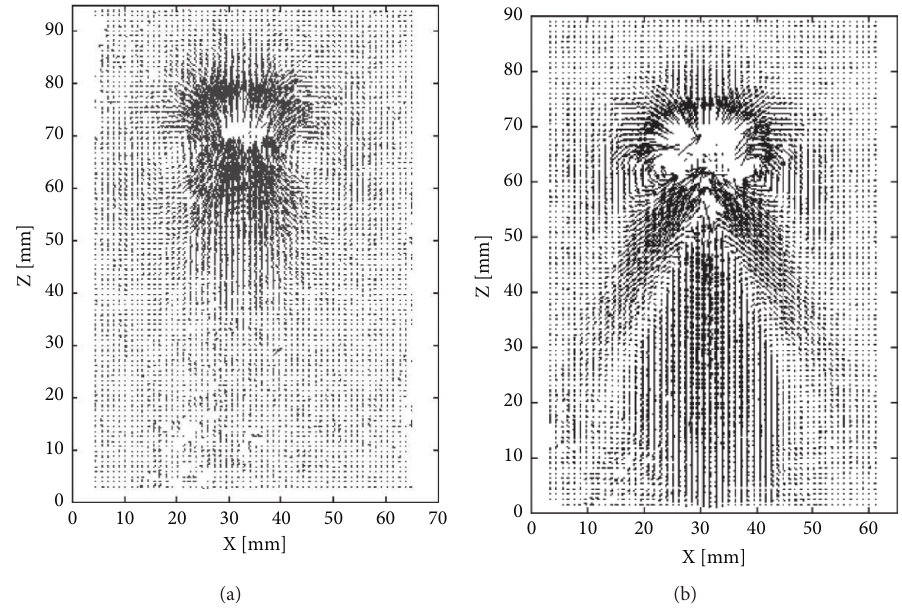
Figure 8: Flow field around a bubble in (a) a Newtonian fluid (glycerine solution) and (b) a viscoelastic fluid (0.75% PAAm solution)